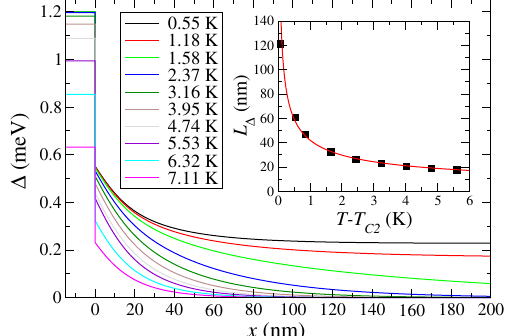
FIG. 4. The main panel shows the computed order parameter in the Pb monolayer as a function of the distance to the island edge for different temperatures. The critical temperature of the mono- 1 . 51 K, while it is T layer is, within BCS theory, T C 2 ¼ C 1 ¼ FIG. 5. Inverse proximity effect in the S 1 island at 0.3 K, and 7 . 89 K for the island. The different parameters are those of color-coded experimental dI=dV ð V; x Þ spectra across the S 1 - S 2 Fig. 2(f), and the temperature dependence of Δ 1 has been taken junction. One spectrum is plotted every nanometer. The four- into account. The inset shows the temperature dependence of the decade log color scale allows one to visualize two important decay length L Δ of the induced order parameter for temperatures effects as one approaches the S 1 - S 2 interface: (i) reduction of above T (see text for a definition). The symbols correspond to C 2 the peak energy and amplitude (pink narrow dI=dV > 1 band) the values extracted from the curves shown in the main panel, and (ii) appearance of a tail of induced subgap states in the while the red solid line is a numerical fit of those results to a ffiffiffiffiffiffiffiffiffiffiffiffiffiffiffiffi ≤ Δ p region Δ 2 ≤ eV 1 . bias T − T function of around 1 = C 2